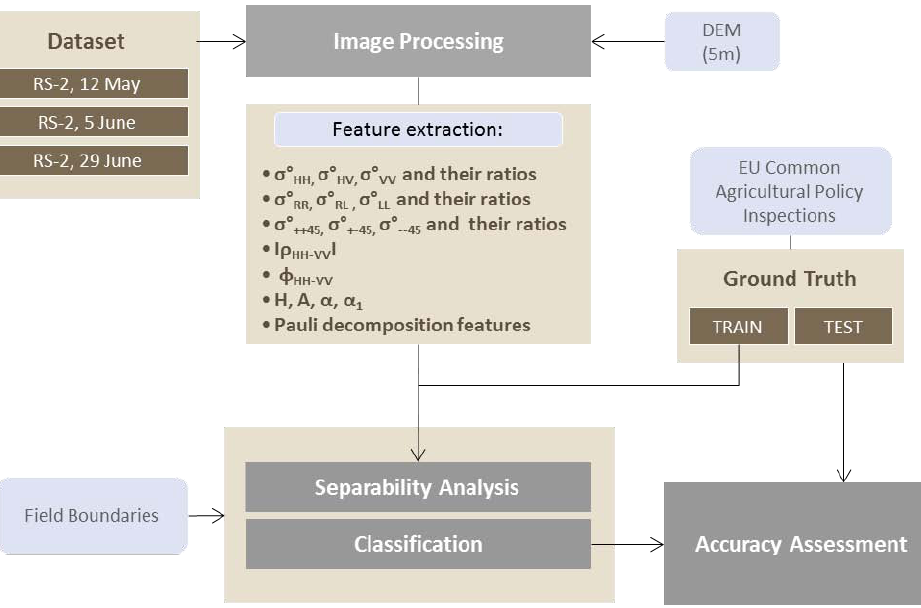
Figure 4. Work-flow chart of the